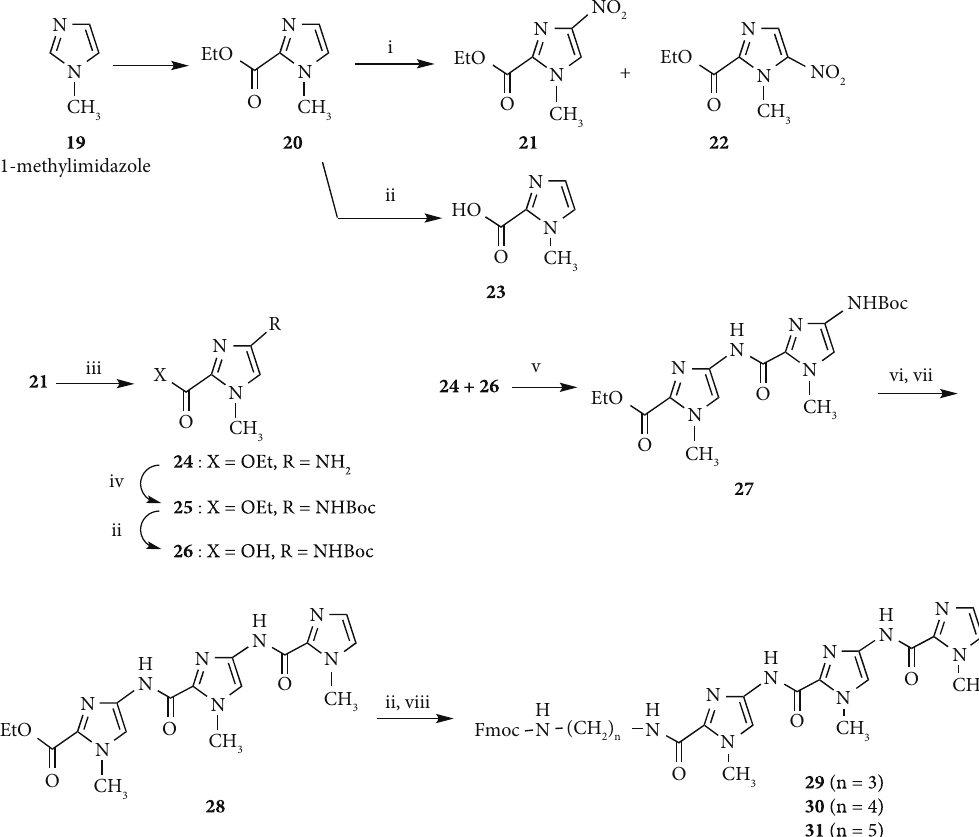
fi ed dsDNAs and respective Δ T